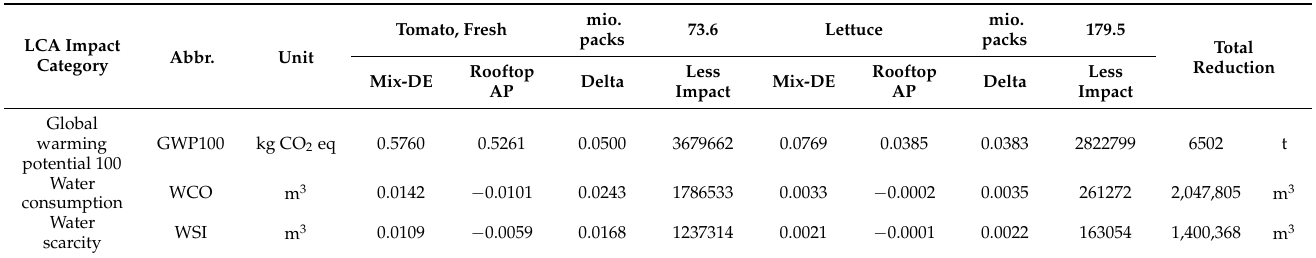
Table 5. Upscaled-AP scenario: Reduced impact of fresh tomato and lettuce production on three LCA impact categories; author’s work and the calculation based on data from comparative-LCA [41]. LCA Impact Category